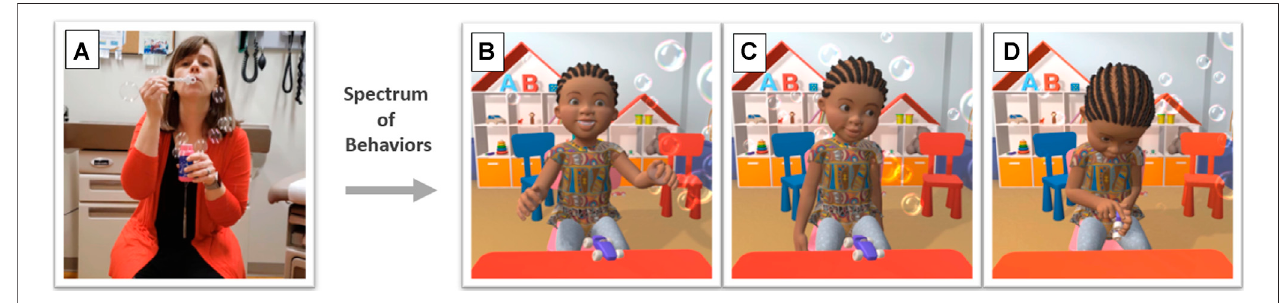
FIGURE 1 | Spectrum of simulated behaviors of JAYLA toward the examiner ’ s action. (A) : The examiner is blowing bubbles, (B) : JAYLA shows age-appropriate behaviors, (C) : JAYLA shows mild autism behaviors, (D) : JAYLA shows severe autism behaviors.